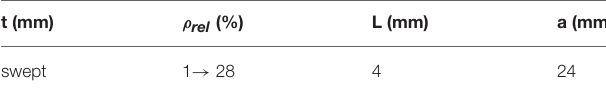
TABLE 1 | Dimensions of the metastructures